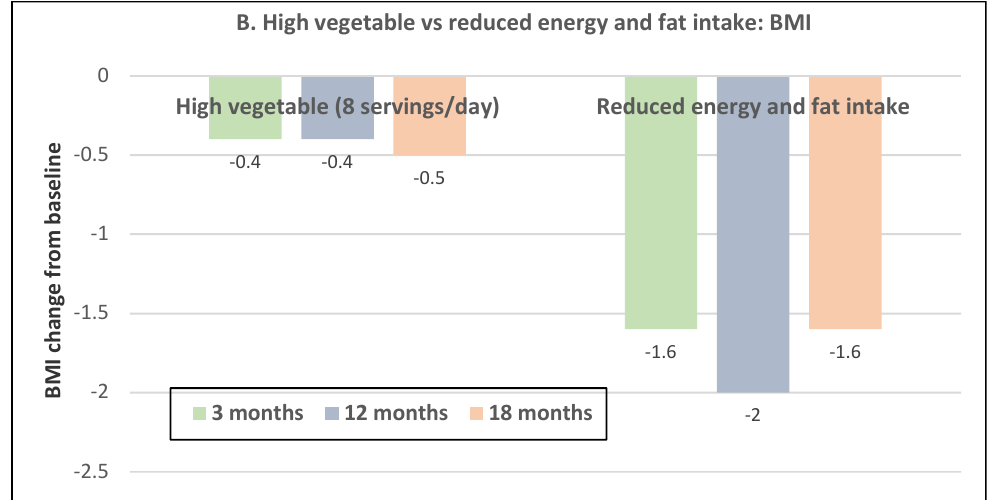
Figure 13. Change in weight and BMI vs. baseline in obese adults (73% obese women; mean age 34 years) for high vegetable (8 servings/day) intake or weight loss diet (500 kcal reduced energy intake) over a three-month intervention and up to 18 months follow-up: ( A ) high vegetable diet reduced weight after three months ( p = 0.0087) with an increase back to baseline at 12 and 18 months, and reduced energy and fat intake reduced weight at three months (<0.0001), 12 months ( p = 0.0006), and 18 months ( p = 0.019), and ( B ) high vegetable diet reduced BMI at three months ( p = 0.014) which remained reduced for the 15 months of follow-up, and the reduced energy and fat diet reduced BMI which remained reduced for all follow-up periods ( p ≤ 0.045) [46]. High vegetable group was requested to avoid potato chips, fried vegetables, or 100% fruit or vegetable juices, but post hoc dietary analysis showed that potato chips, French-fried potatoes, 100% vegetable juices were counted as part of the goals and 2–3 servings of fruit including fruit juice. Premenopausal women—dietary approach #6—varying percent energy from fat and servings of FV. High FV intake, including 100% juice, dried fruit, and starchy vegetables, reduced weight, and % body fat with 16–17% energy from fat compared to an increase in weight and % body fat with 29% energy from fat (Figure 14) [47].